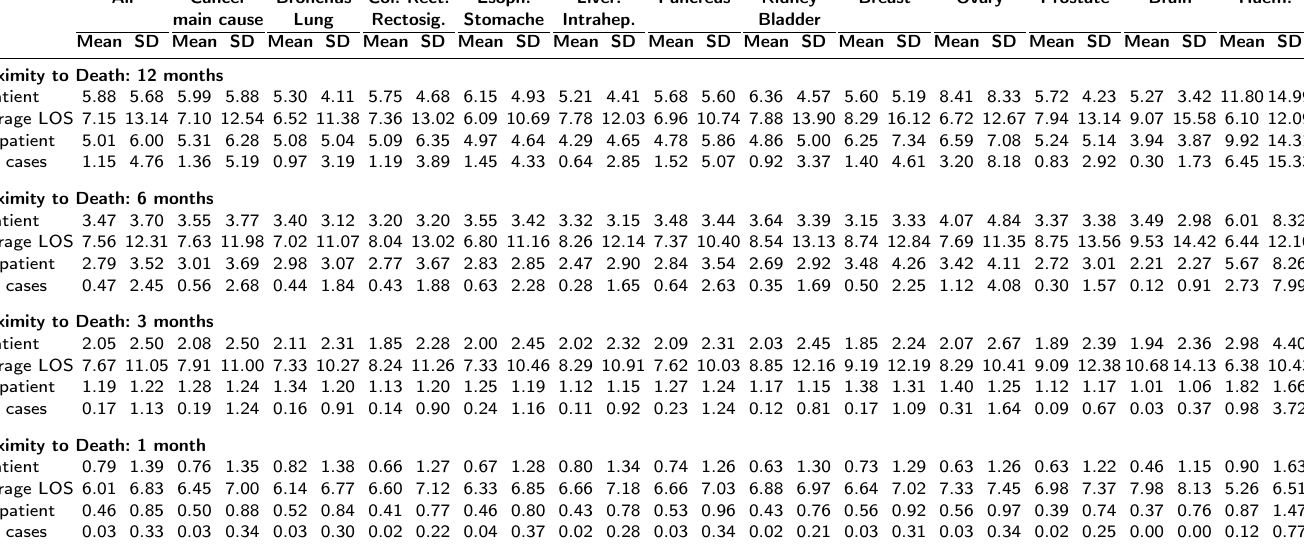
Supplementary Table 1: Resource use (Inpatient, Inpatient LOS, Outpatient appointments and daycase use) over proximity to death (last 12, 6, 3, 1 month) by cancer type All Cancer Bronchus Col. Rect. Esoph. Liver. Pancreas Kidney Breast Ovary Prostate Brain Haem. main cause Lung Rectosig. Stomache